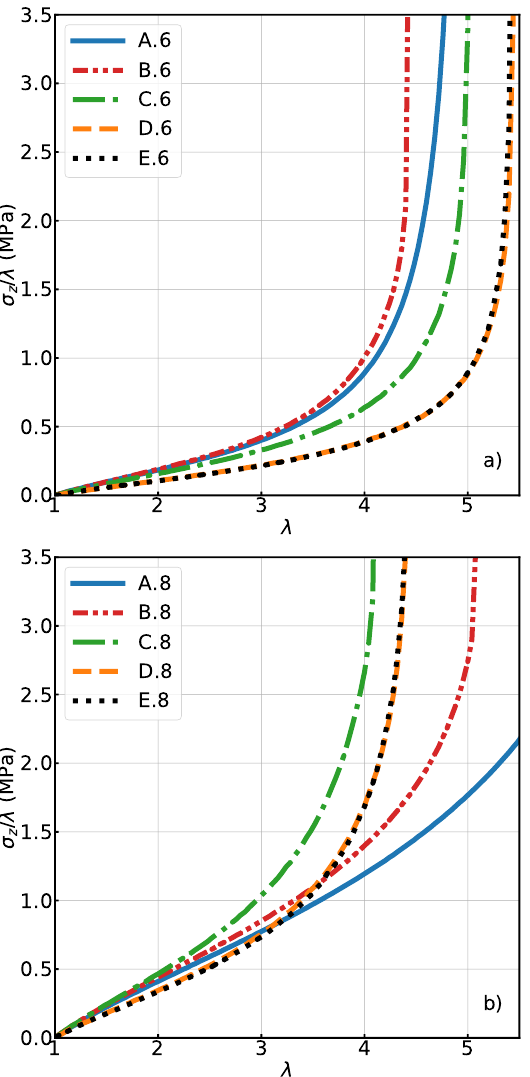
Figure 3. The load vs. stretch diagrams (uni-axial deformation) for systems of ( a ) with connectivity 6 and ( b ) with connectivity 8. (see Table 1 for a complete description of the